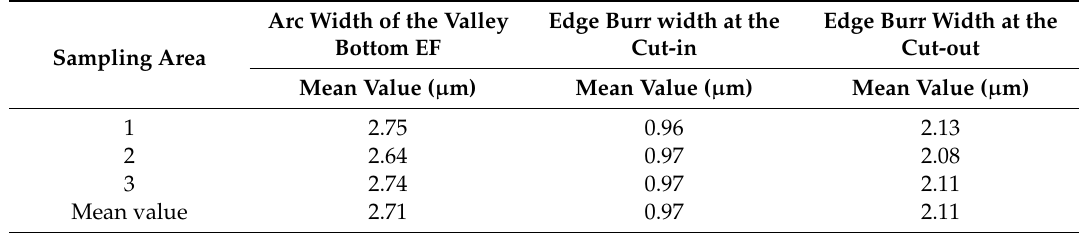
Table 4. Arc width of the valley bottom and burr projection width.